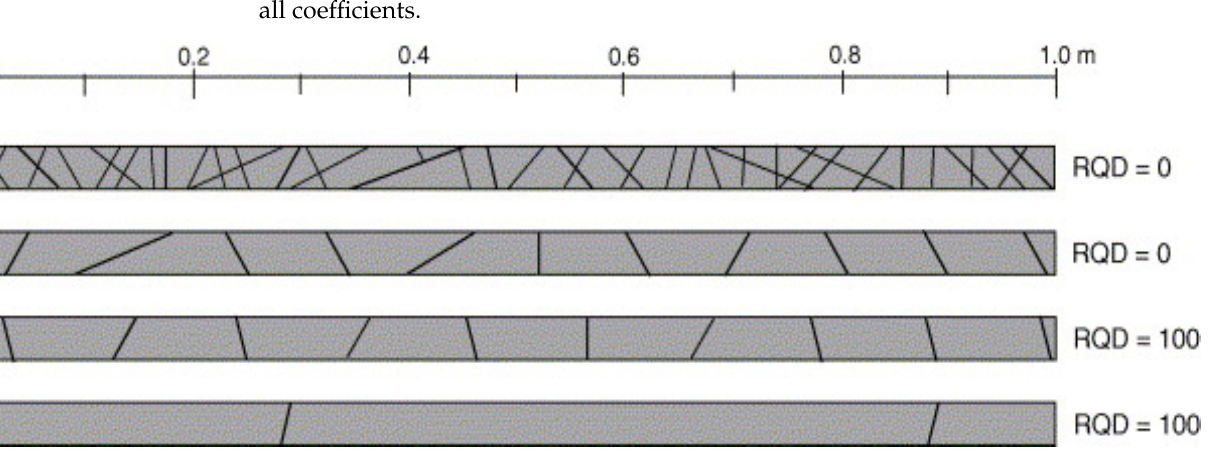
Figure 1. Examples of minimum and maximum values of RQD for various joint densities along drill cores (Reprinted with permission from Ref. [17]. Copyright 2022, Elsevier).